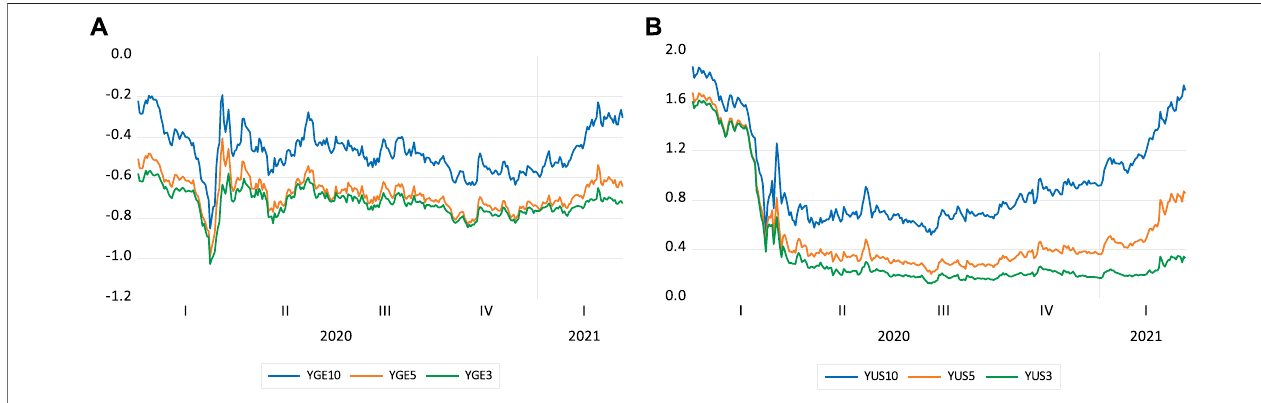
FIGURE 2 | Dynamics of Germany (A) and United States (B) government bond yields at different maturities (2020/02/01 – 2021/19/03).Note: M1 = January; M2 = February; M3 = March; M4 = April; M5 = May; M6 = June; M7 = July; M8 = August; M9 = September; M10 = October; M11 = November; M12 =December; for variable abbreviations see Table 1